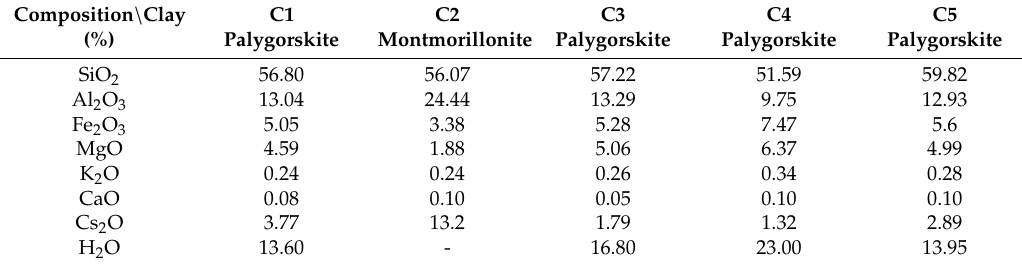
Table 2. Chemical composition of palygorskite as the most dominant mineral in clays (C1, C3, C4 and C5 *) and that of montmorillonite for C2 clay measured by Analytical transmission electron microscopy